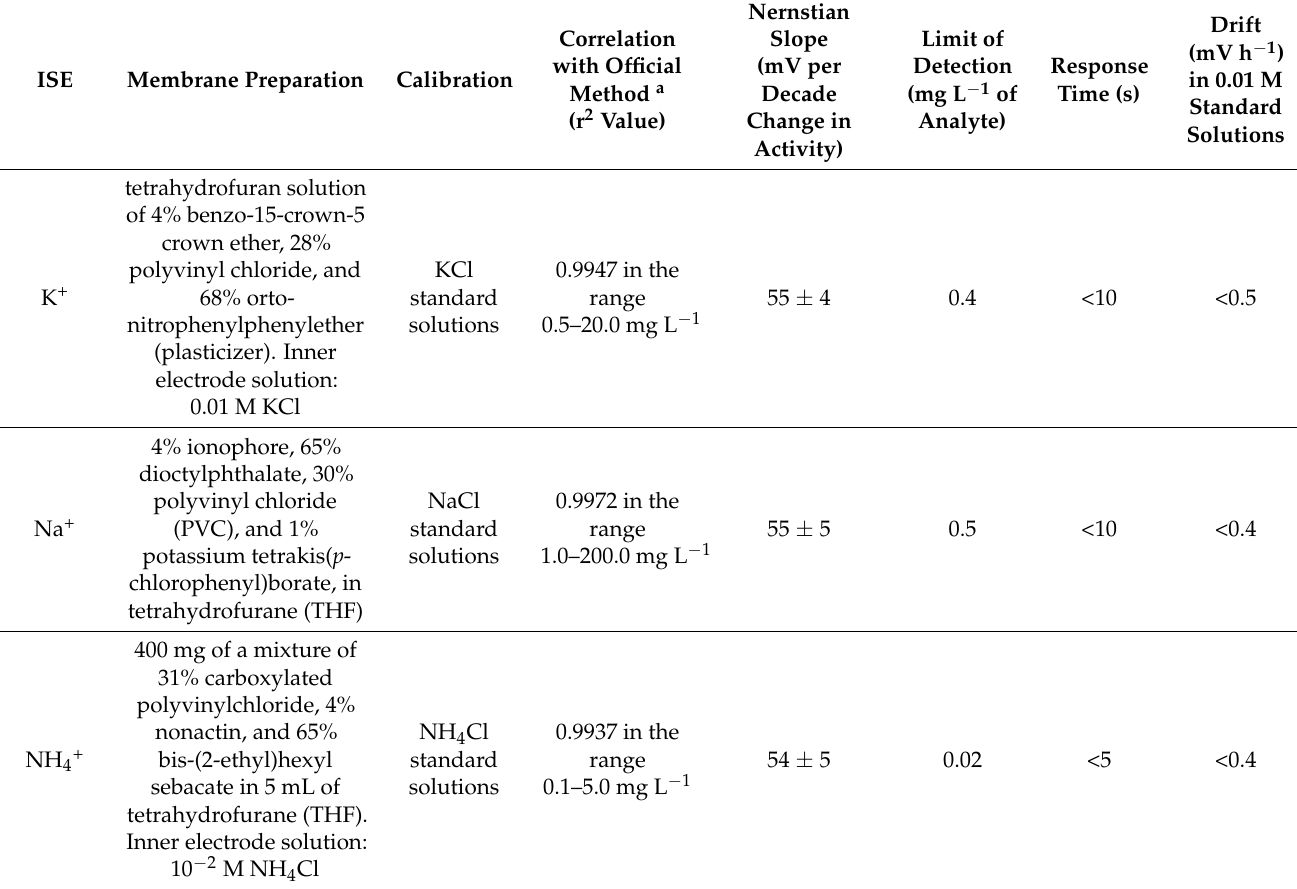
Table 1. Main features of the three Ion Selective Electrodes (ISEs)